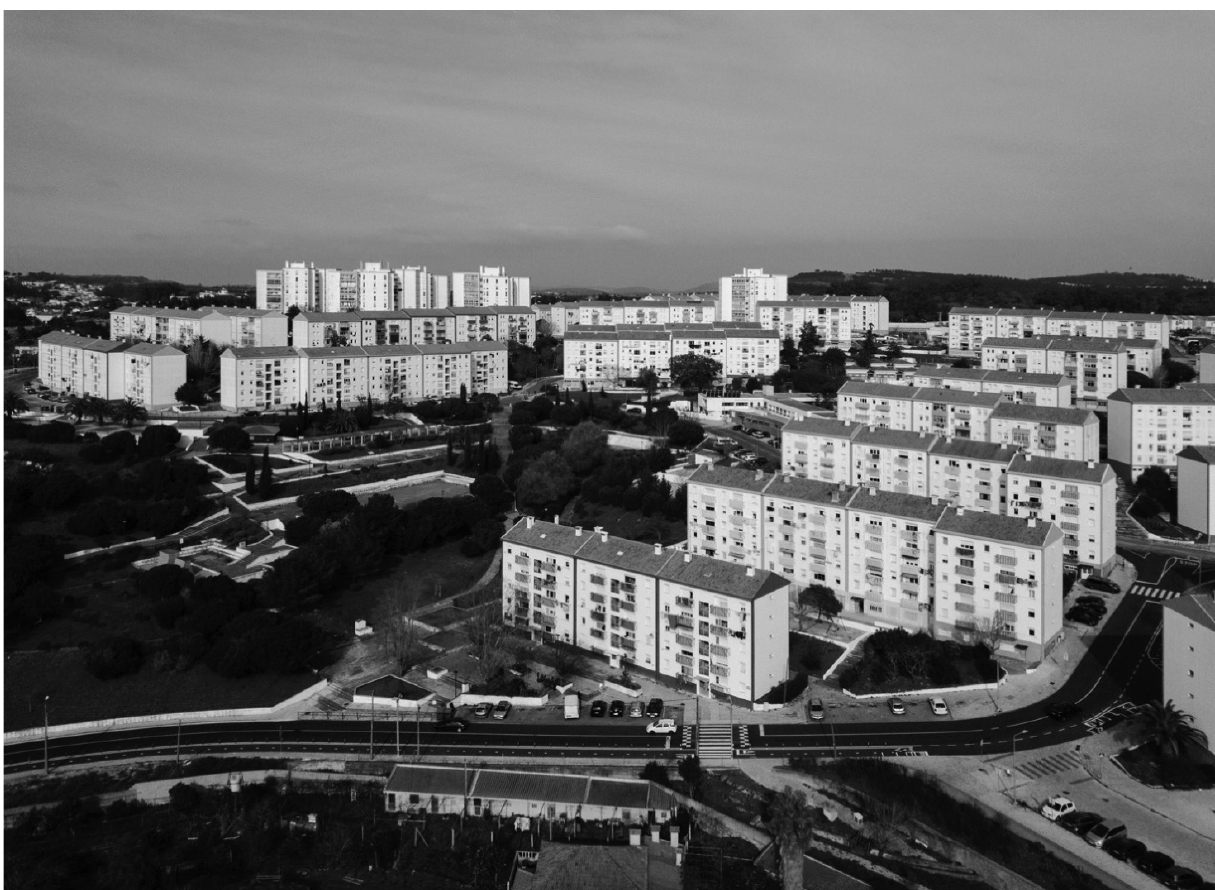
Figure 7. Agualva‐Cacém affordable housing estate in Mira‐Sintra, 1965 (reference a267 in MdH database). Photograph by © Tiago Casanova. Source: Ramos, Gonçalves, et al. (2019).